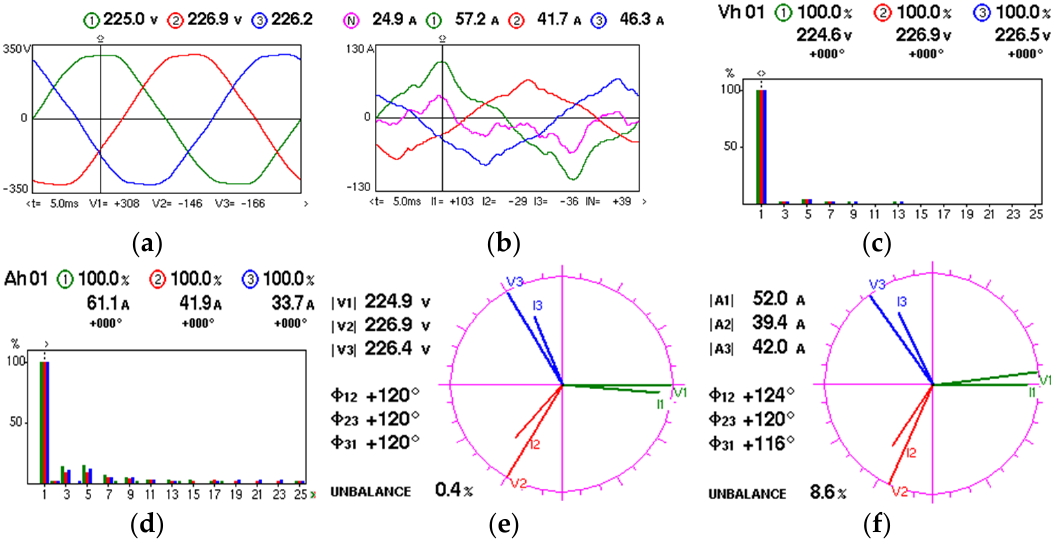
Figure 22. Current and voltage transients from the electrical power substation.